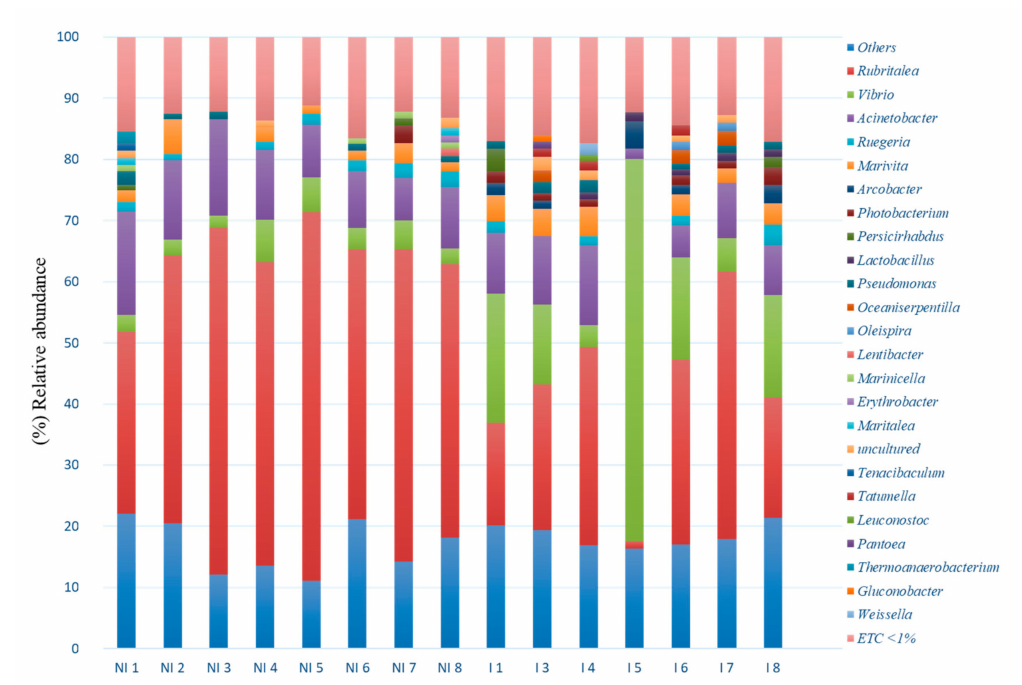
Figure 9. Relative abundance (%) at genus level of the individual skin mucus microbiota of non-infected (NI) and infected (I) fish. ETC: relative abundance < 1%.